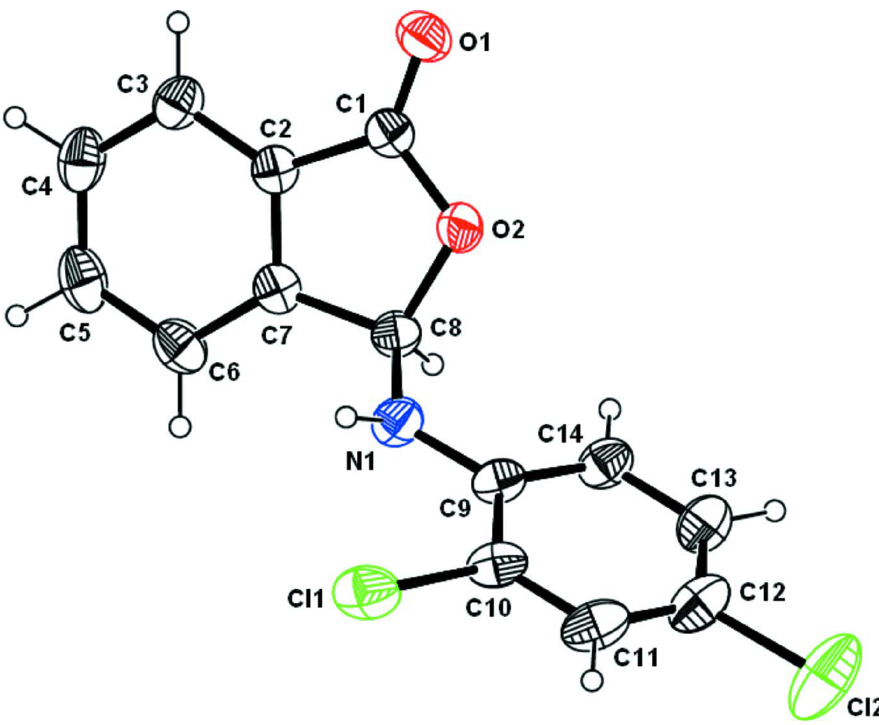
Figure 1 The molecular structure of the title molecule, with the atom-numbering scheme. Displacement ellipsoids are drawn at the 30% probability level.